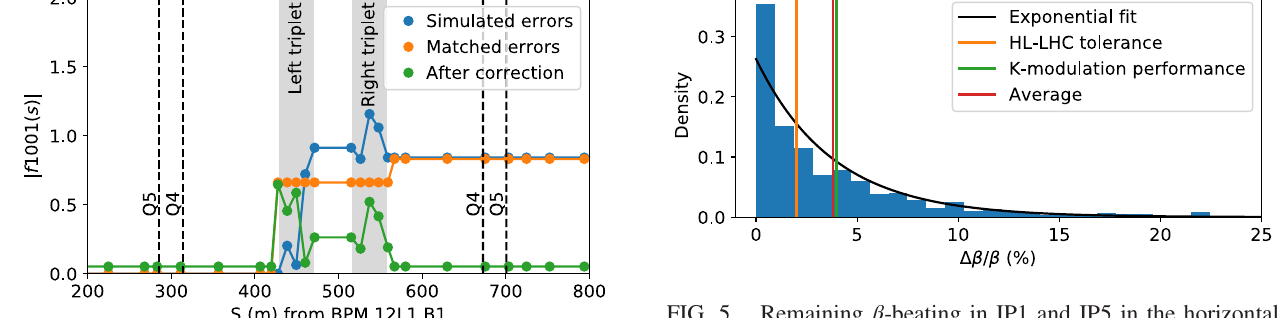
quadrupole.FIG. FIG. 6. Relative difference between the magnetic errors of each seed and the correction implemented in each triplet